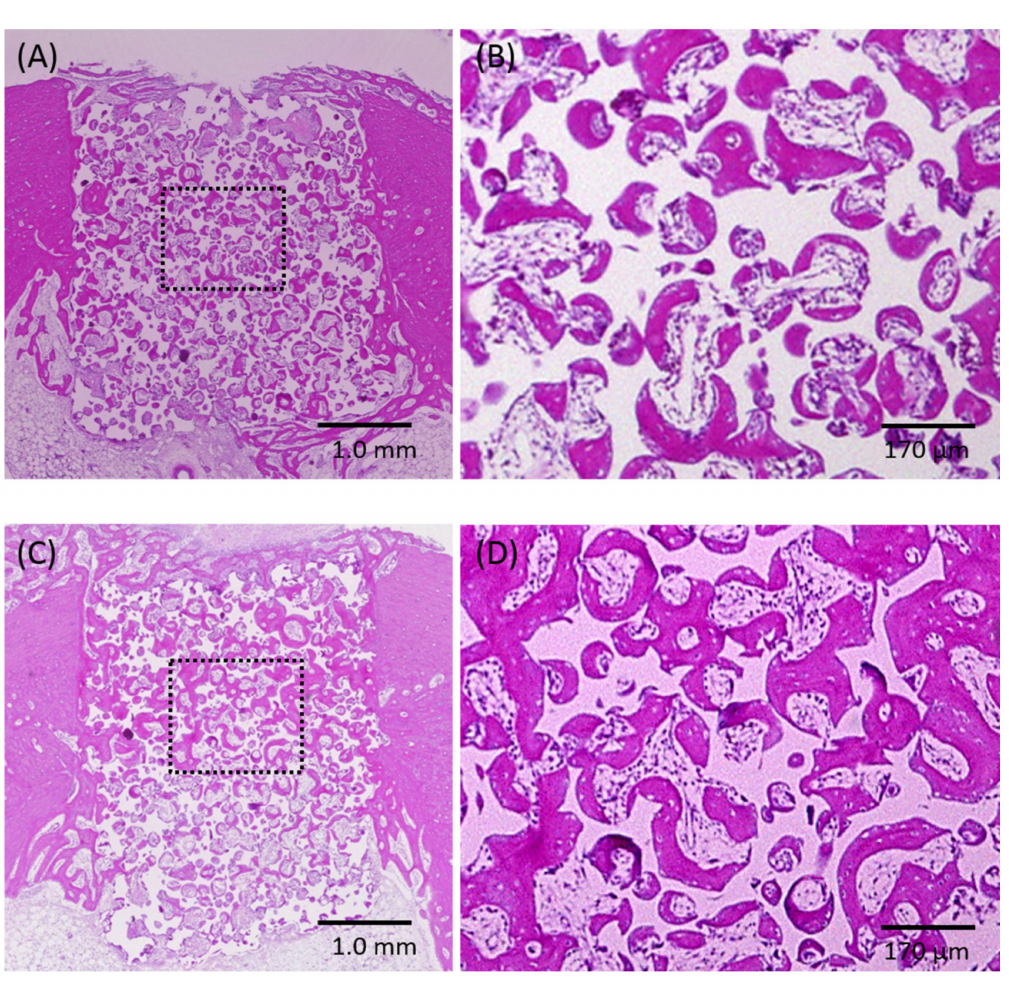
Figure 2. Histological specimens of porous HA ( A , B ) and phosphate treated HA ( C , D